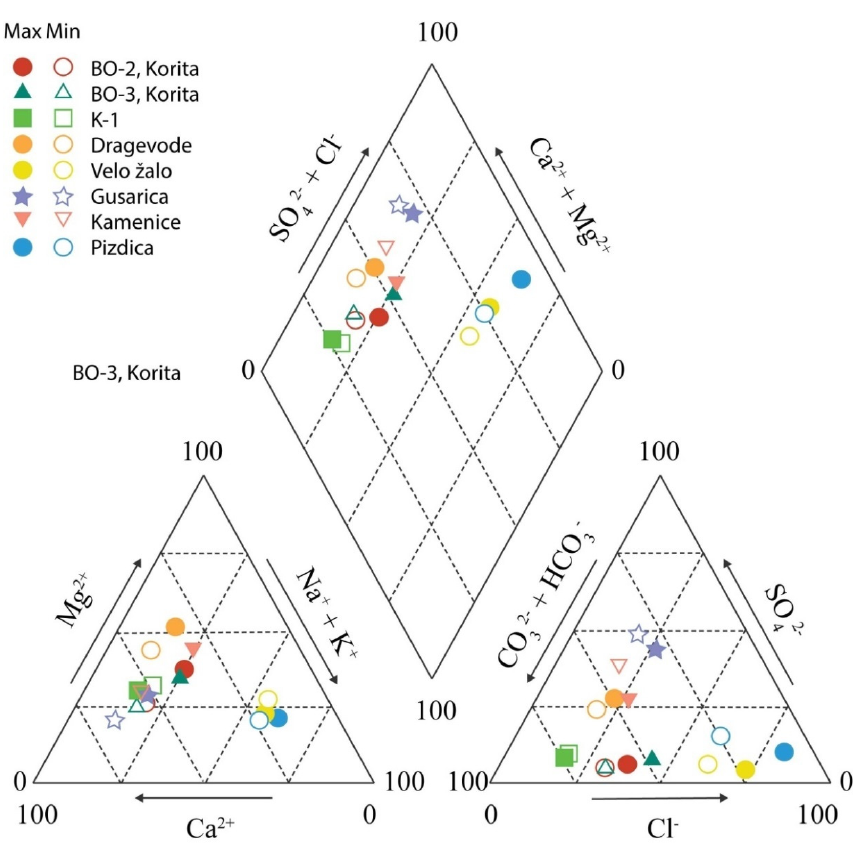
Figure 8. Piper diagram of groundwater samples from Vis Island. “Min” and “Max” represent the low GWL in June 2000 and the high GWL in December 1999, respectively. Table 3. Basic ion composition of the spring and wells on Vis Island.